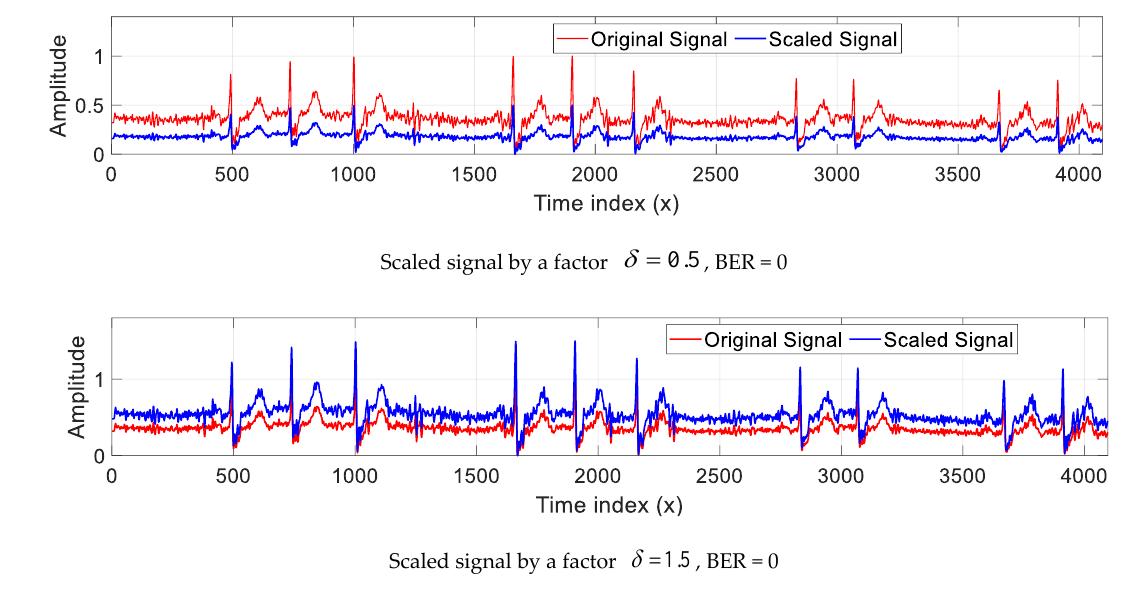
Figure 22. Original ECG signal and its amplitude scaled versions with the corresponding BER values.